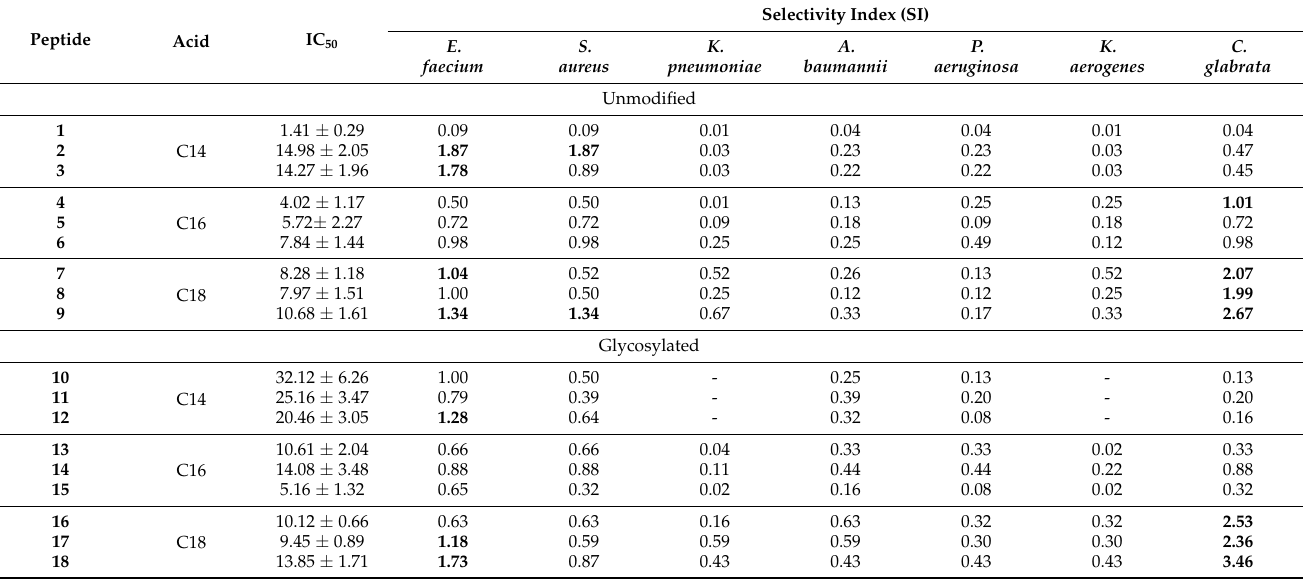
Table 5. Cytotoxicity (IC 50 [ µ g/mL]) and selectivity indexes of 1 – 18